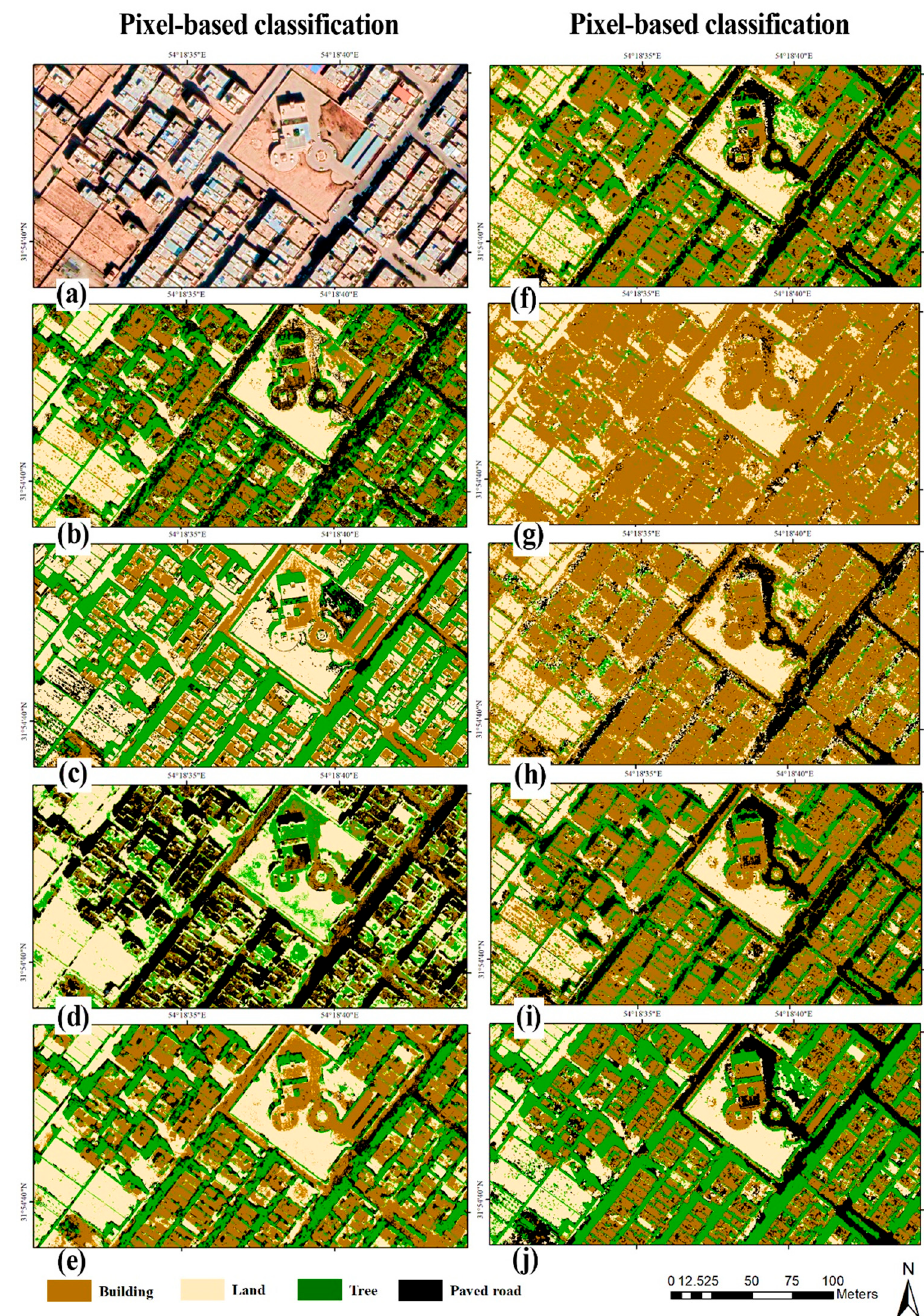
Figure 5. Classification of Google Earth images obtained using pixel-based methods ( a ) Google Earth image, ( b ) maximum likelihood method, ( c ) minimum distance method, ( d ) spectral angle mapping (SAM) and ( e ) Mahalanobis method; and object-based methods: ( f ) Bayes method, ( g ) support vector machine (SVM), ( h ) K-nearest neighbor (KNN), ( i ) decision tree (DT) and ( j ) random forest (RF). The kappa coefficient and overall accuracy values for Google Earth image classifica- tion using the different methods are shown in Table 3. Among the pixel-based methods, maximum likelihood had the highest accuracy (kappa coefficient = 0.75, overall accuracy = 80%) and SAM had the lowest accuracy (kappa coefficient = 0.39, overall accuracy = 47%). The minimum distance and Mahalanobis methods had kappa coefficients of 0.41 and 0.56, respectively (Table 3) In general, the pixel-based methods tested did not have the appropriate accuracy for separating land cover in urban areas.